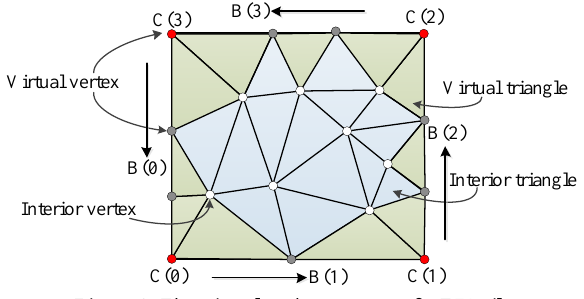
Figure 2. The virtual node structure of a TIN tile.